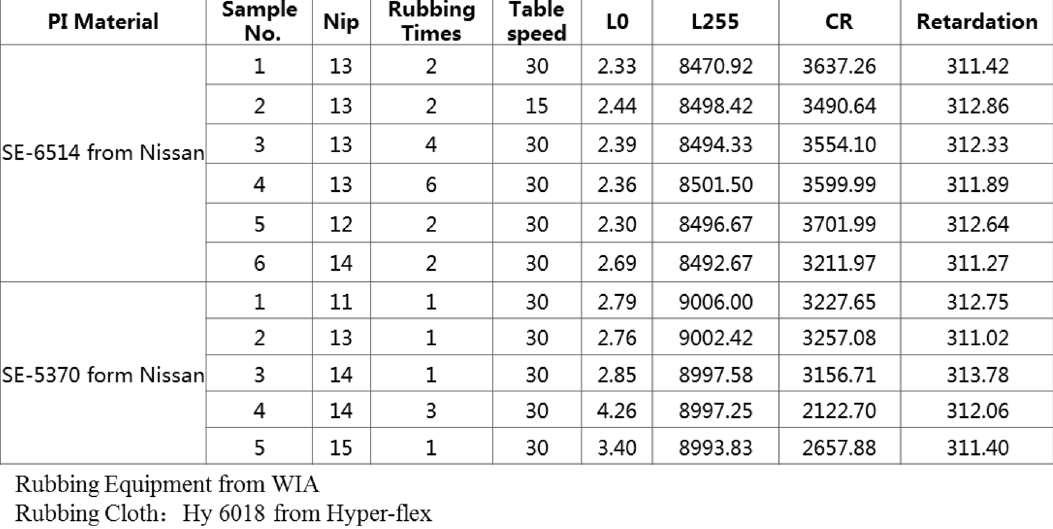
Figure 9. The CR of +A at different alignment condition.